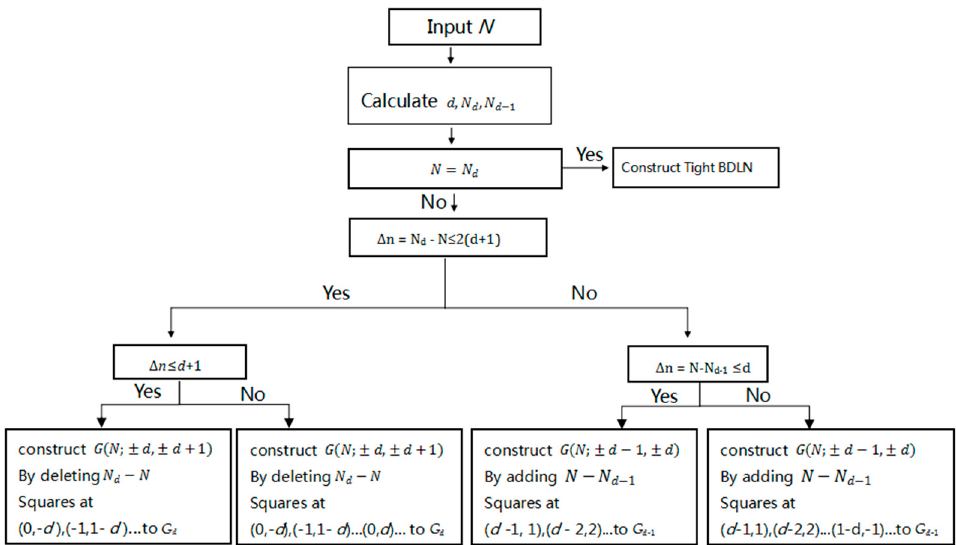
Figure 9. Algorithm for constructing a dual optimal BDLN.